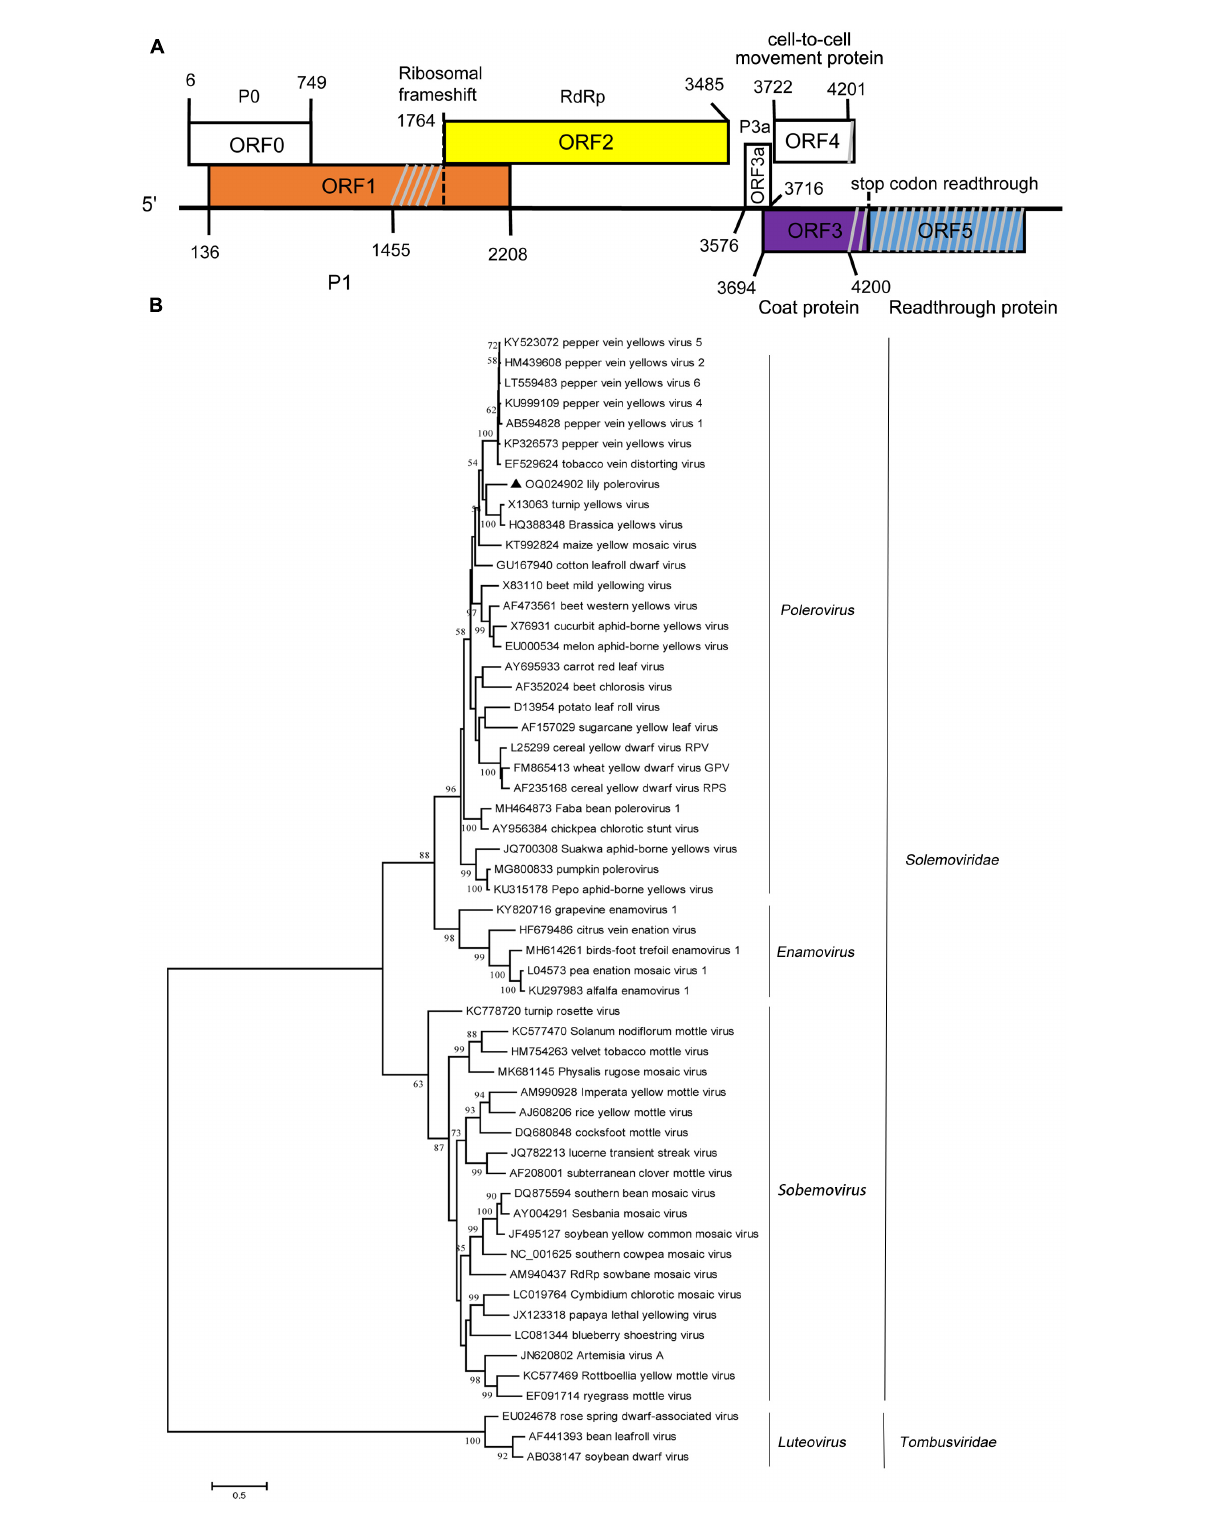
FIGURE2 (A) Schematic representation of the genomic organization of lily-associated polerovirus 1 (LaPV-1). The nucleotide positions of the protein domain sites were listed. P0, P1 (orange), RdRp (RNA-dependent RNA polymerase, yellow), P3a, cell-to-cell movement protein, coat protein (purple), and reading through protein (blue) were proteins encoded by LaPV-1. Gray slash lines indicate the nucleotide gap in this region. (B) Phylogenetic analyses of the viruses in the Solemoviridae based on the amino acid sequences of RdRp, constructed with the maximum-likelihood (ML) method with 1,000 bootstrap replicates. Bootstrap values are given by numbers at the relevant nodes in the topology and only bootstrap values of ≥ 50% were shown. LaPV-1 was indicated with solid black